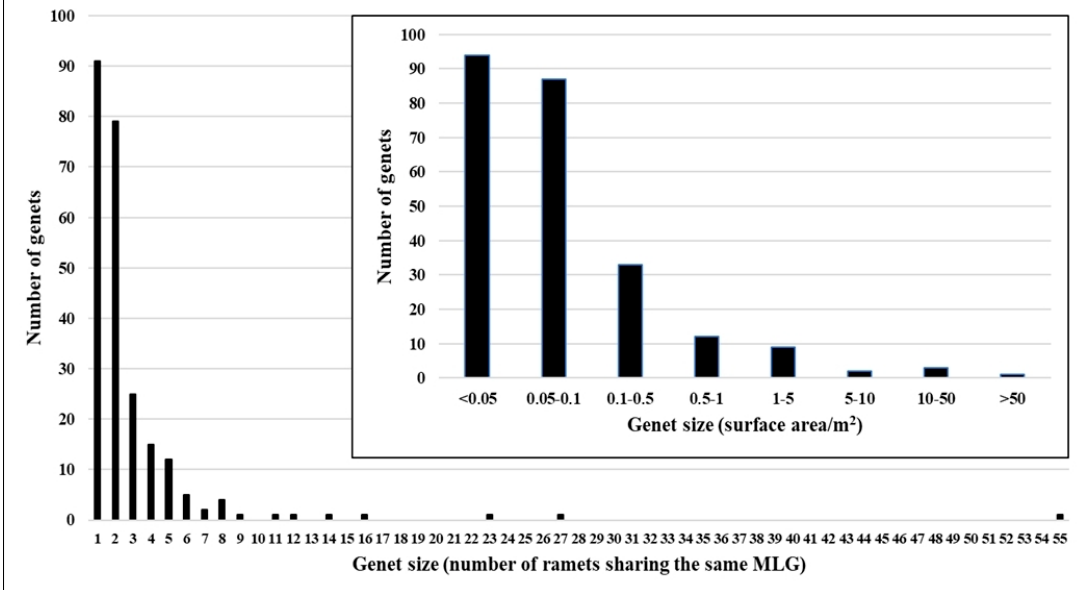
Figure 5. Distribution of genets in accordance with their size: (1) main plot—genet size in terms of the number of sampled ramets sharing the same multilocus genotypes (MLG), (2) small plot—genet size ( A GEN ) in terms of the surface areas (m 2 ) occupied by the individual genets (represented by convex hull polygons for MLGs with at least three collected ramets and by buffer polygons for MLGs with one or two collected ramets).